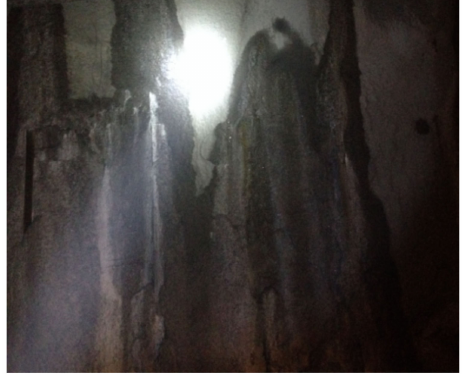
Figure 20. Grouting e ff ect of pure cement